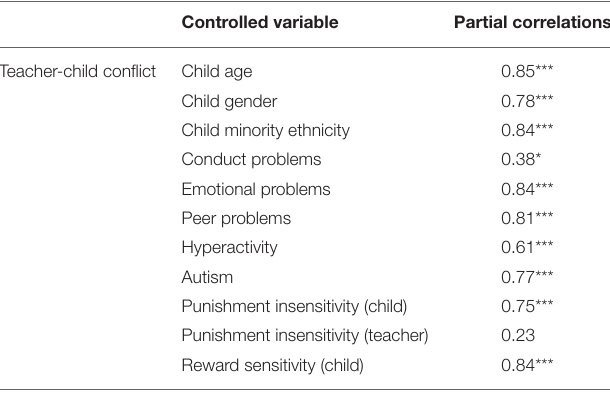
TABLE 3 | Partial correlations between CU Traits and Teacher-Child Conflict, Controlling for Potential